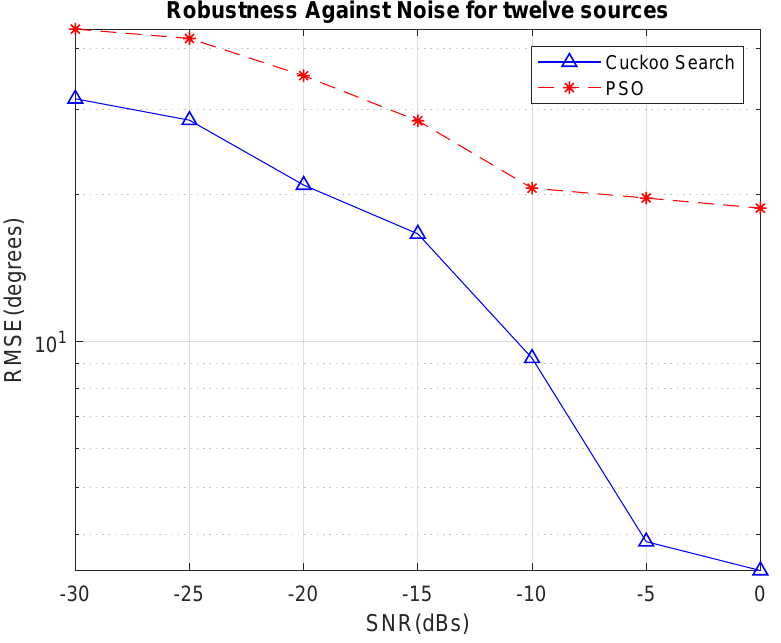
Figure 6. Robustness against noise for twelve sources.